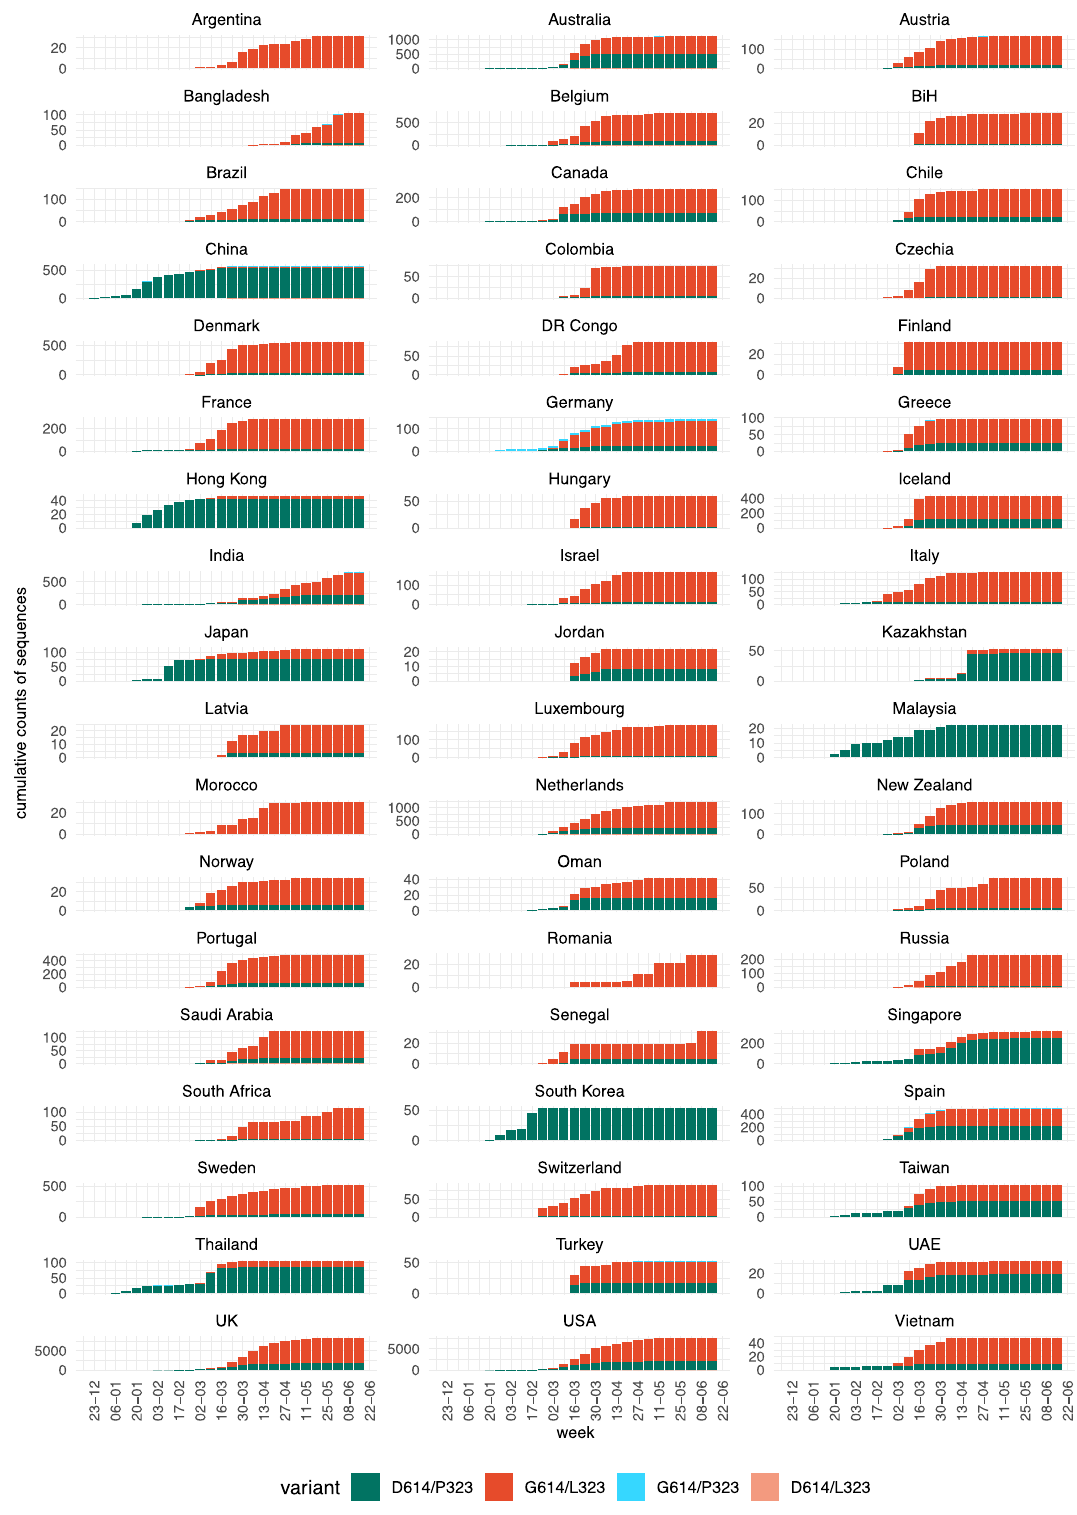
Figure 5. Temporal evolution of the four possible D614G and P323L variants in different countries. Available high-quality sequences of SARS-CoV-2 (27 075) were analysed for the different possible combinations of the D614 and G614 variants of the spike protein and the P323 and L323 of the RdR polymerase based on country of origin of the sequences. Only countries with at least 20 sequences were included in this analysis. Results are shown as cumulative number of sequences over time (the weekly number of sequences is provided as a Supplementary Figure